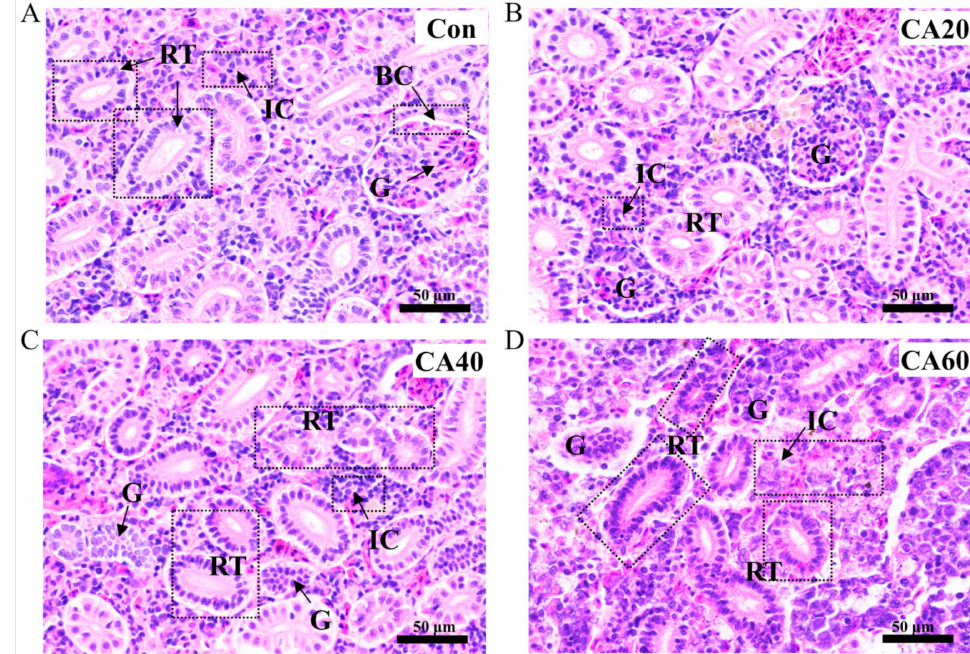
Figure 2. The renal histological alterations of crucian carp under different concentrations of carbonate alkali exposure. ( A ) the freshwater control group: normal histological structure, glomerulus (G), renal tubules (RT), Bowman’s capsules (BC), interstitial cells (IC). ( B ) 20 mmol/L NaHCO 3 exposure group: glomerular atrophy, renal tubular degranulation and interstitial cell proliferation. ( C ) 40 mmol/L NaHCO 3 exposure group: glomerular atrophy, renal tubular obstruction and interstitial cell prolifer- ation. ( D ) 60 mmol/L NaHCO 3 exposure group: glomerular atrophy and swelling with widened Bowman’s capsules, renal tubular degeneration and swelling, renal interstitial edema and interstitial cell necrosis. (H&E, × 400, scale bar: 50 µ